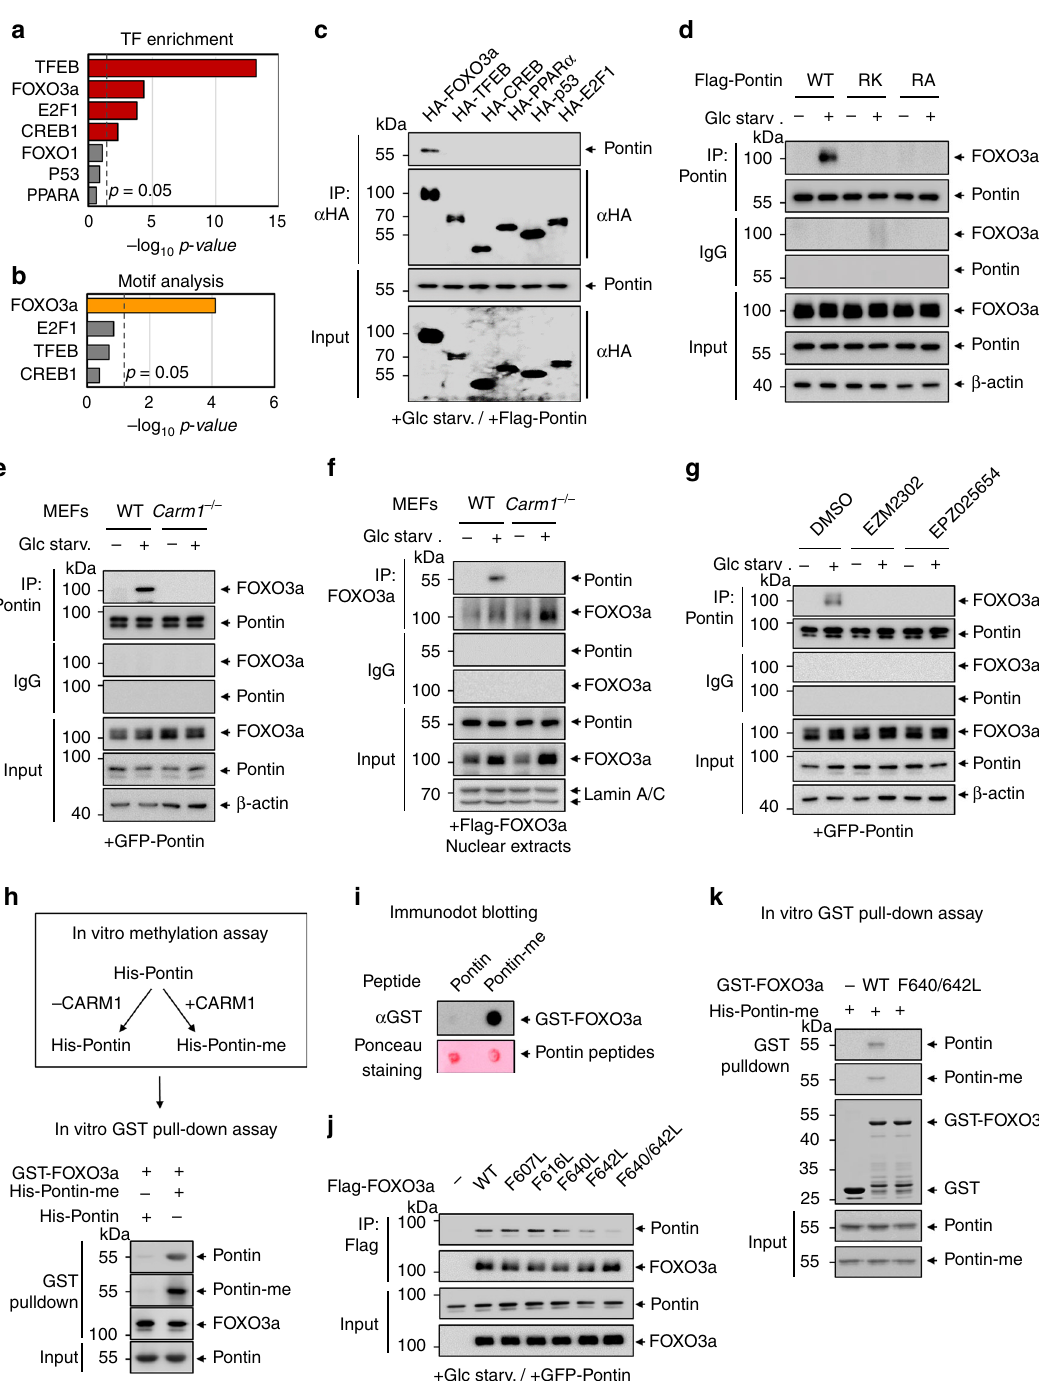
Fig. 5 Methylated Pontin binds FOXO3a through the arginine methyl-binding domain of FOXO3a. a Transcription factor enrichment analysis for the methylated Pontin-dependent genes using EnrichR software. b Binding motif analysis using methylated Pontin ChIP-seq data. Hypergeometric p -values were calculated. c Co-immunoprecipitation assay was performed to detect the interaction between Pontin and various autophagy-related